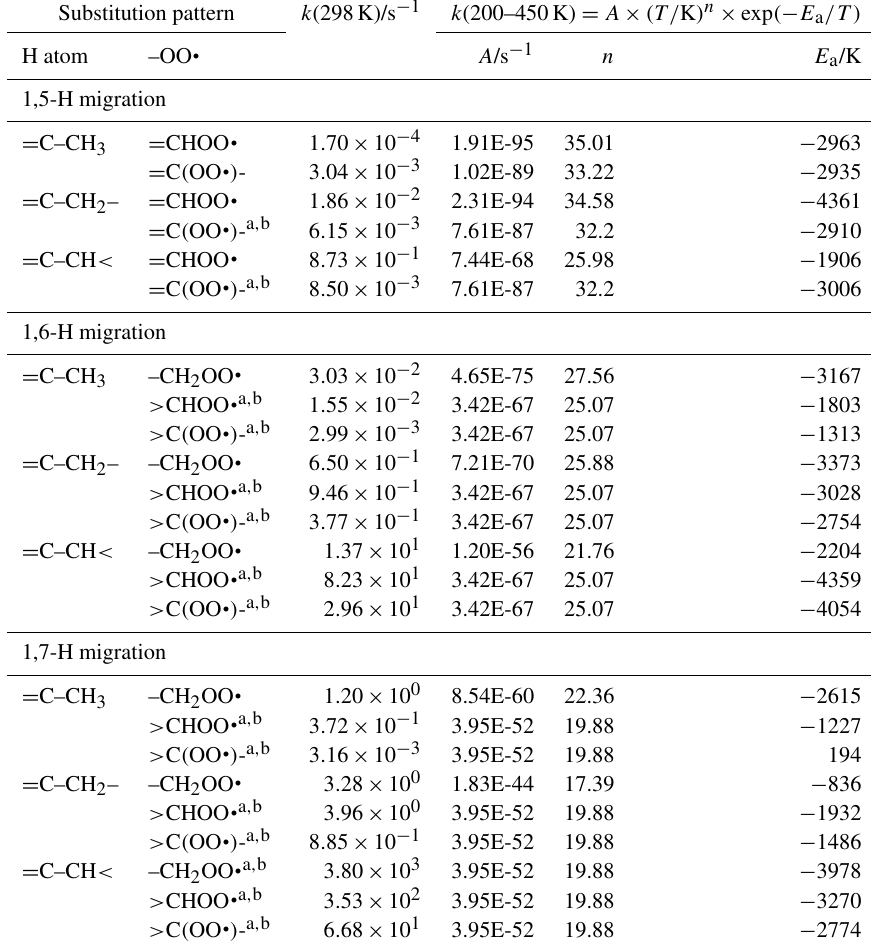
Table 2. Rate coefficients for allylic H migration in peroxy radicals with an endocyclic double bond within the TS ring, accounting for all abstractable H atoms in the group. These rates apply only to migration between cis - or gemini